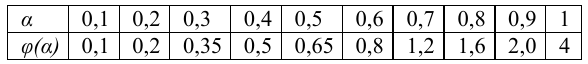
Table 2. Values of the conditional sound absorption